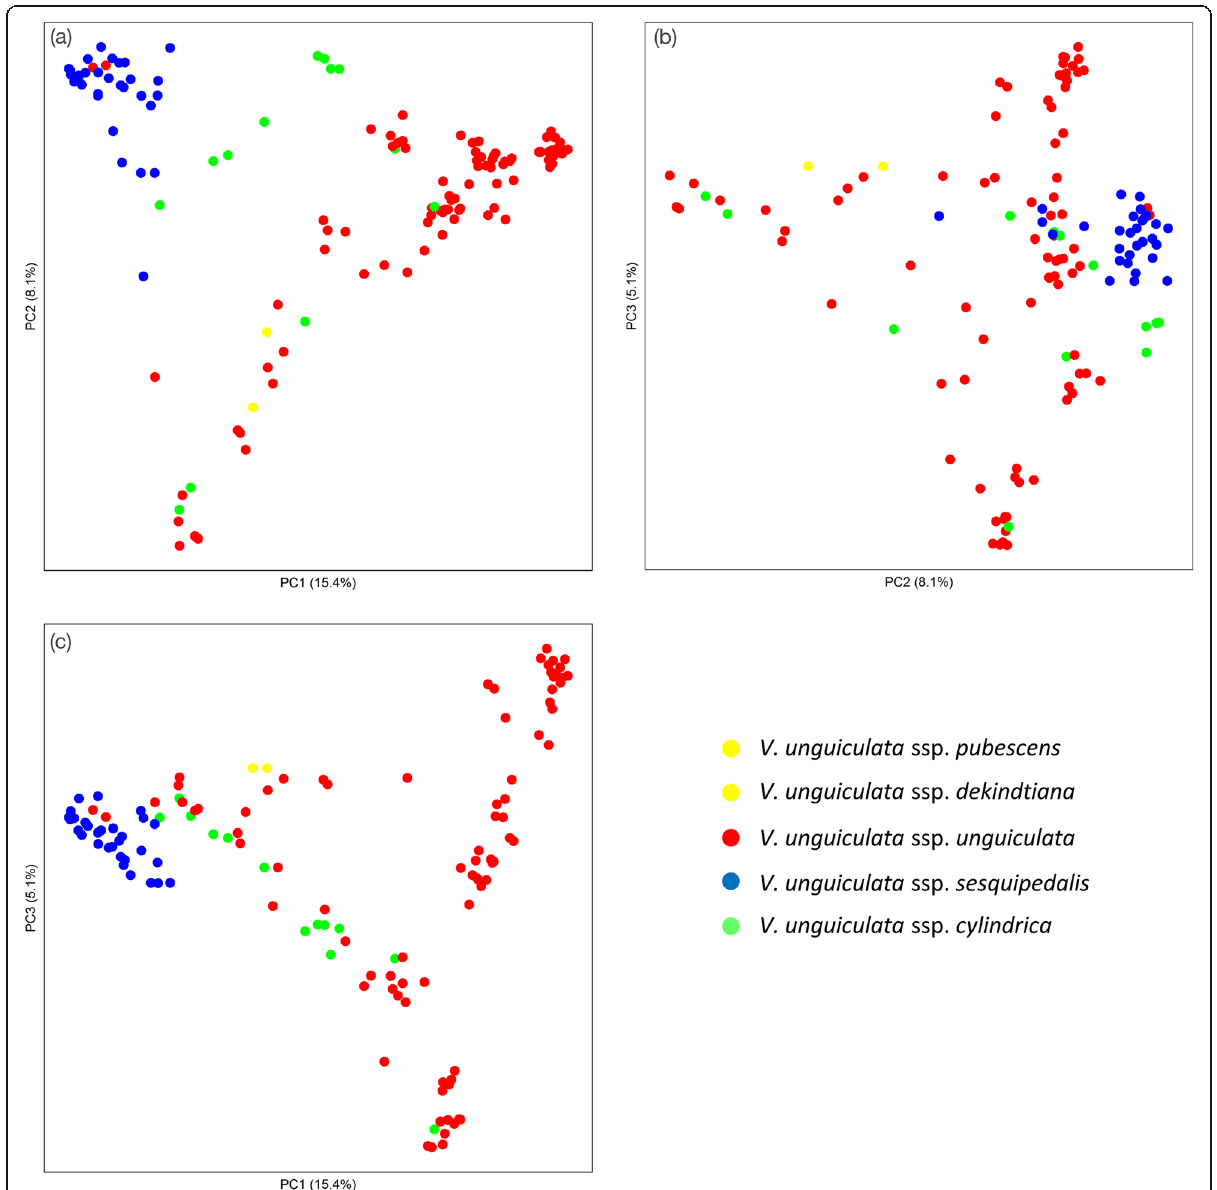
Fig. 1 Visualization of the genetic relationships among three domesticated cowpea subspecies by Principal Component